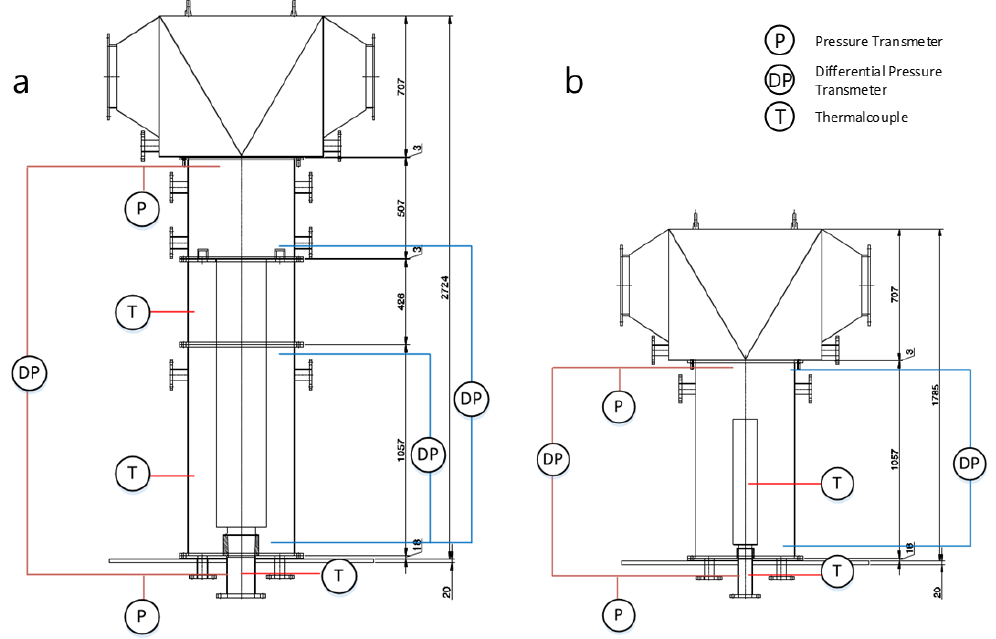
Figure 4. Instrumentation of test section: ( a ) full-scale; ( b ) half-scale.